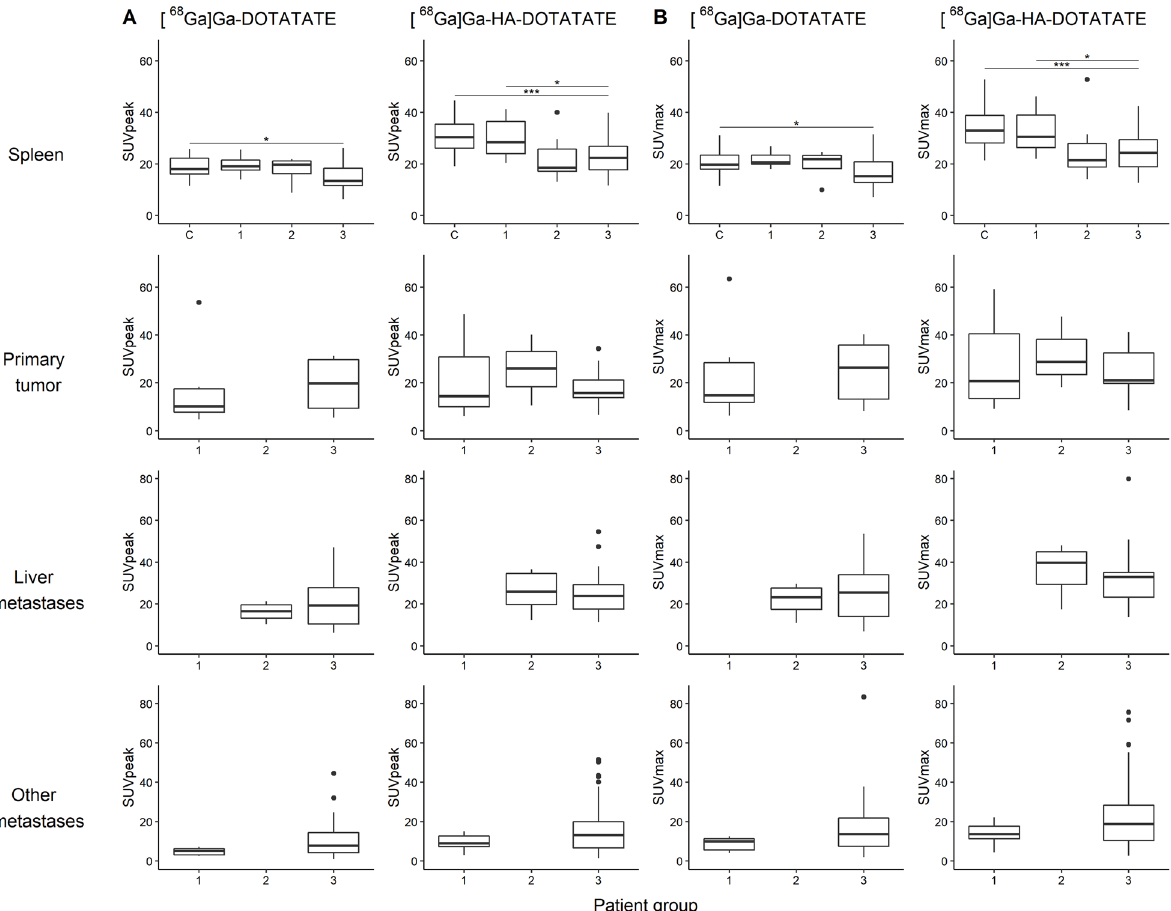
Fig. 4 Spleen and tumor uptake (SUV peak ( A ) and SUV max ( B )) of [ 68 Ga]Ga‑DOTATATE and [ 68 Ga]Ga‑HA‑DOTATATE for: (C) control group, (1) limited disease, (2) liver‑only metastases and (3) extensive metastases patients. Lines indicate significant uptake differences between two groups (*